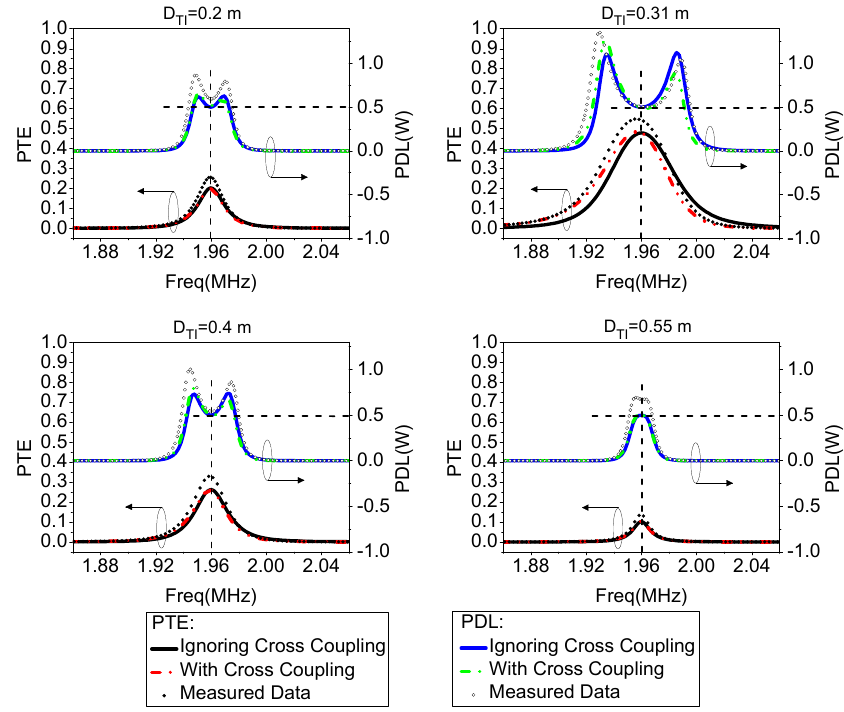
Figure 13. Measured and theoretical results of the predetermined ‐ goal of obtaining a constant PDL at f 0 = 1.96 MHz when transfer distance D TR = 0.7 m.